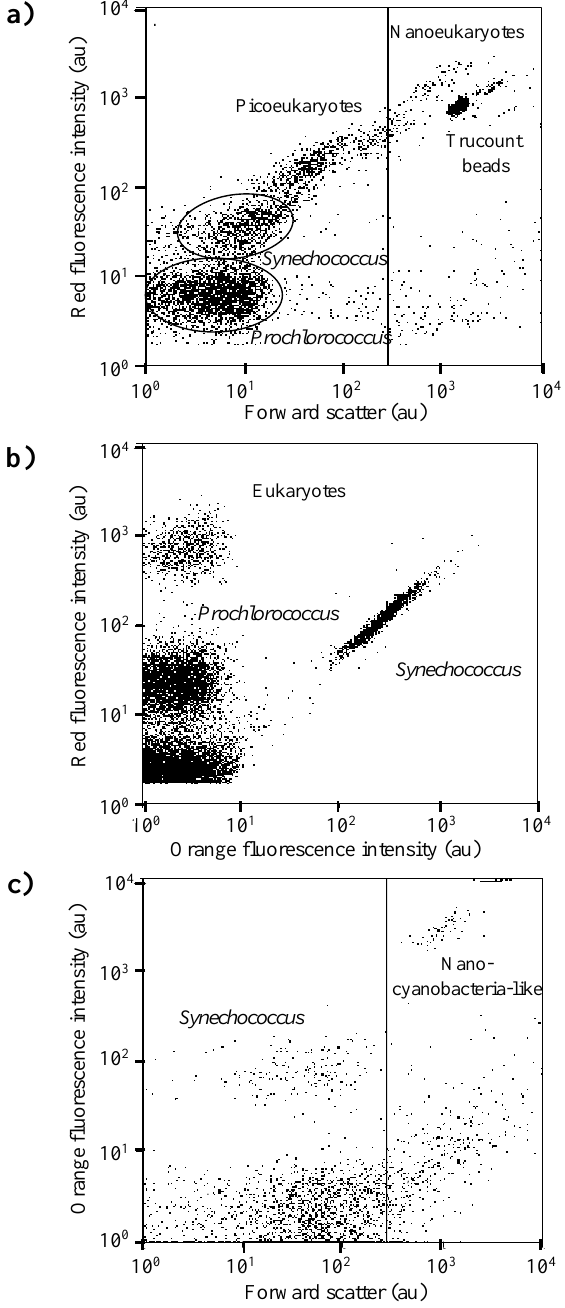
Fig. 3. Resolution by flow cytometry of the ultraphytoplankton as- semblage composition during the Tokyo-Palau cruise. Panels (a) and (b) display cytograms of red fluorescence (chlorophyll a) ver- sus forward scatter (size) and orange fluorescence (phycoerythrin) resolving four cell groups: Synechococcus , Prochlorococcus , pi- coeukaryotes and nanoeukaryotes in samples collected at station 8 (100m depth). Panel (c) displays the orange fluorescence versus forward scatter and discriminates the nanocyanobacteria-like to the Synechococcus in the sample collected at 3m depth of the sta- tion 11. The beads are the Trucount calibration beads (Beckton